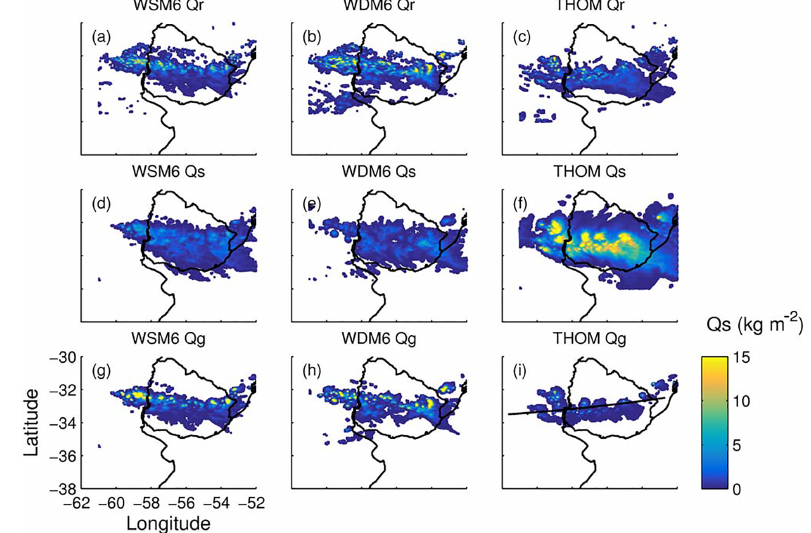
Figure 4. The integrated column content in kgm − 2 for rain, snow and graupel, as simulated by the WRF microphysics options WSM6, WDM6 and THOM, at 19:00UTC with a 0.05kgm − 2 minimum threshold. Note that cloud water and cloud ice are not shown. The black solid line in (i) represents an MHS transect explored in Sect. 4.